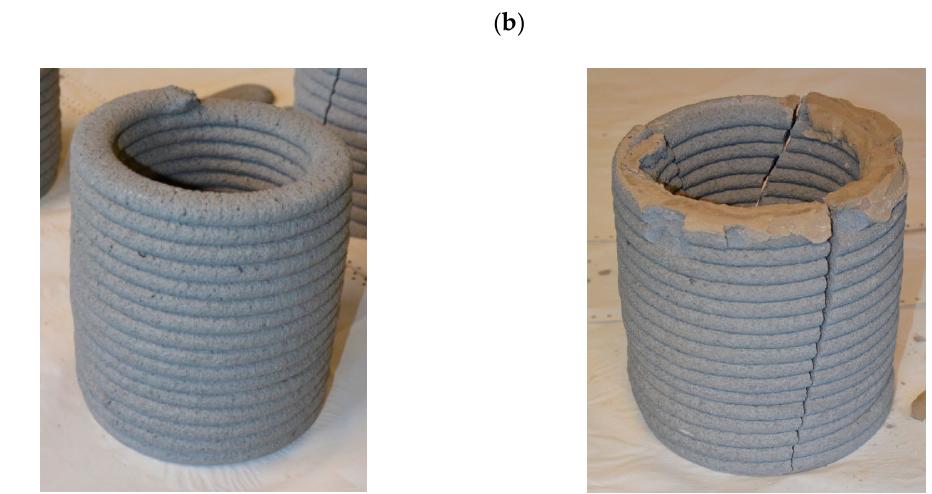
Figure 18. Column printed out of B840/SF/FA/LP: ( a ) after printing; ( b ) after compression test.